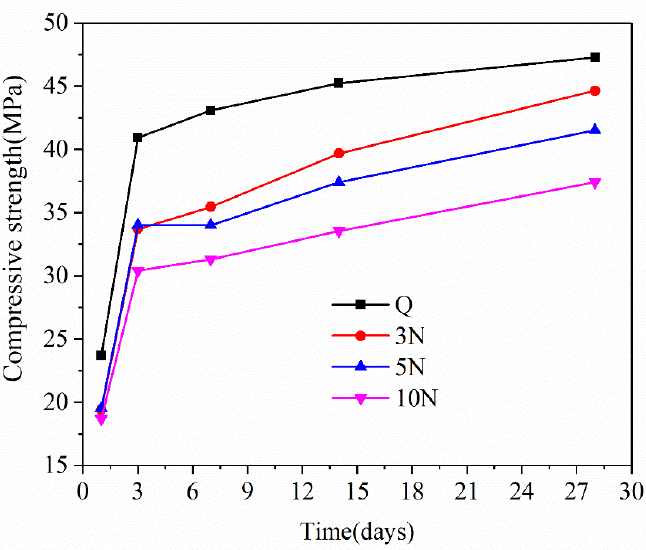
Figure 1. Compressive strength of concrete with different sodium sulfate content varies with